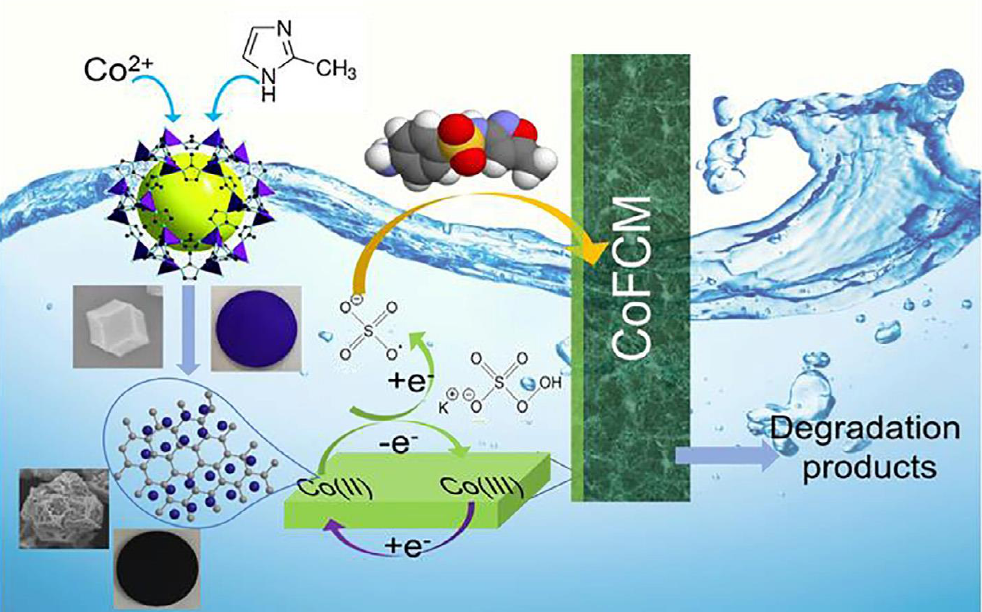
Figure 7. A new reaction mechanism for the degradation of SMX on the surface of ceramic membrane CoFCM [128].